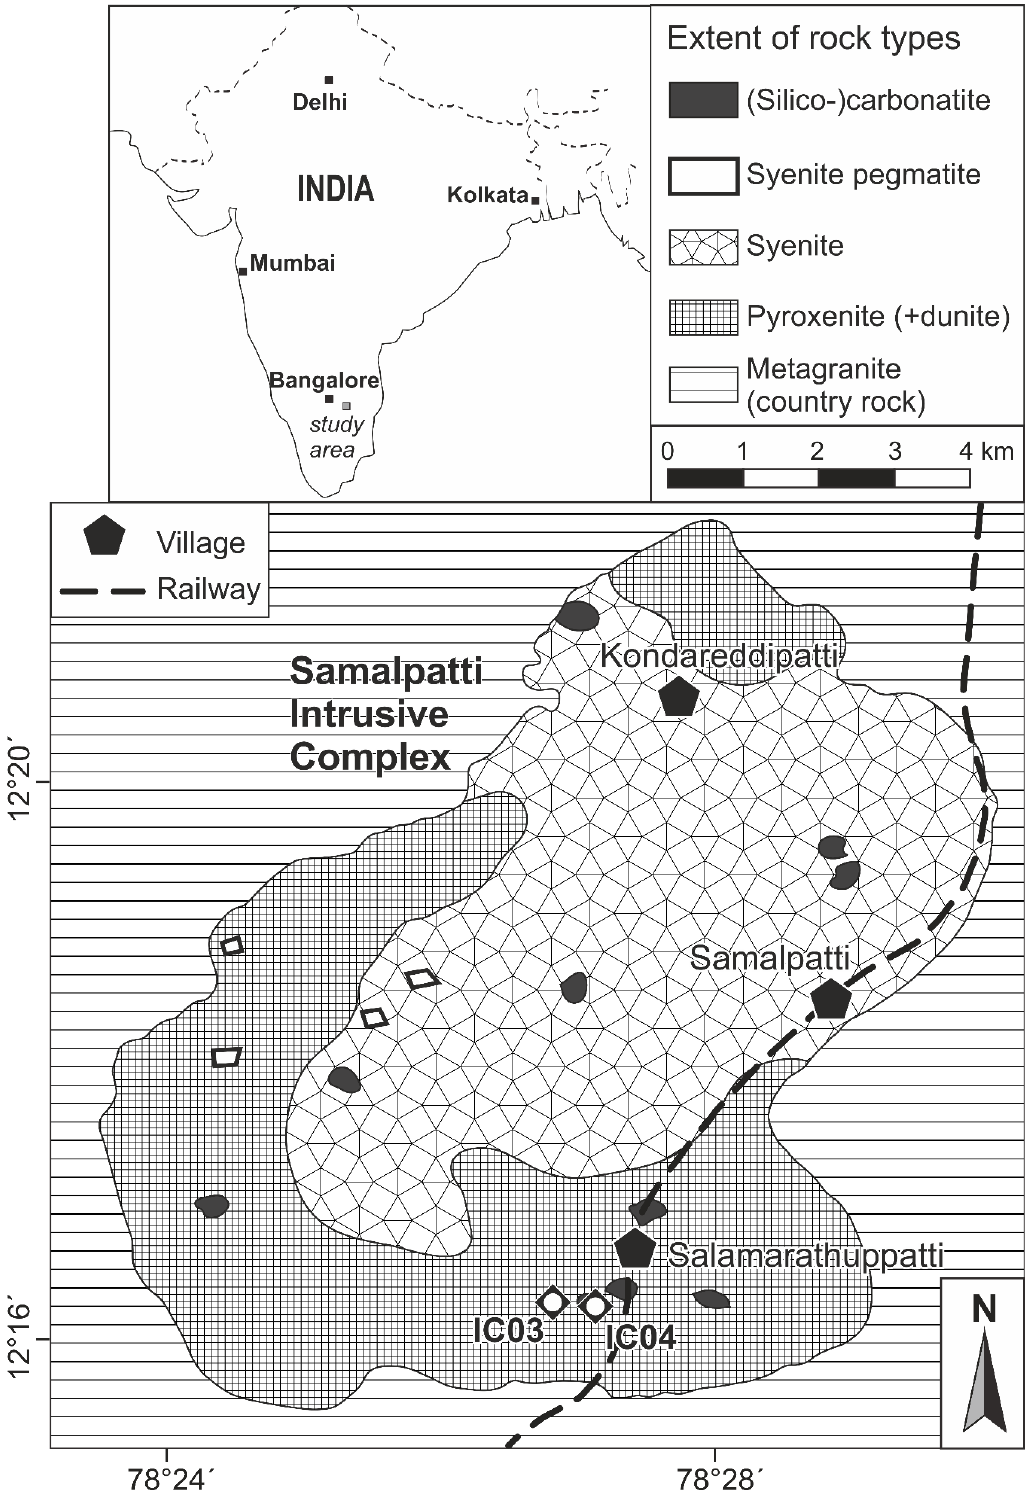
Figure 1. A simplified geological sketch of the Samalpatti carbonatite–alkaline silicate complex (after Schleicher et al. [23]; Srivastava [21]; Ackerman et al. [16]. Sampling sites are indicated.